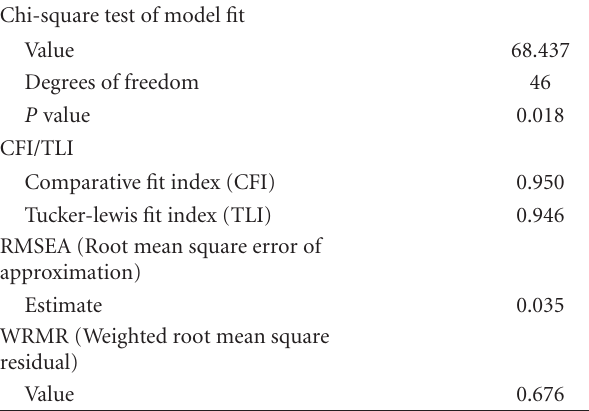
Table 6: The 8 social engagement items form one factor, of four, in the 20-item enacted function profile. Measurement properties of the enacted function profile